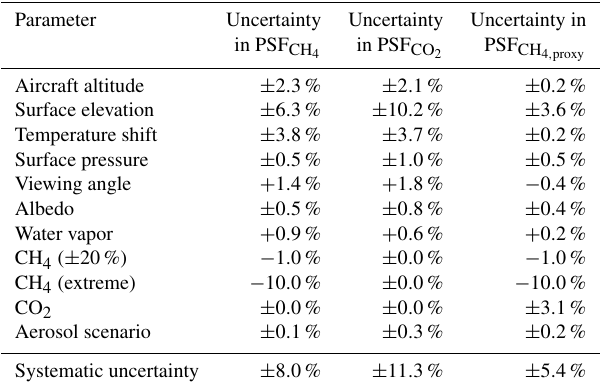
Table 4. Uncertainty estimate resulting from the assumed constant atmospheric and geometric background parameters. For each pa- rameter, the maximum deviations for PSF CH and PSF CO , as well 4 2 as for PSF CH , are listed. For albedo, the largest value was ex- 4 , proxy cluded from this table (see main text). For CH 4 , two different cases are regarded. The case CH 4 ( ± 20%) is valid for most of the plumes and is relevant for detection of smaller sources. The extreme case (100% increase) is only relevant near very strong sources and is excluded from the averaged systematic uncertainty. The absolutely when changing CO 2 is due to the rel- correct retrieval of PSF CO 2 atively small range of change in CO 2 investigated. However, this induces relatively large uncertainties in PSF CH . 4 , proxy Figure 5. Raw retrieval results of CH 4 (pure PSF CH and destriped, no proxy method applied) over a scene with large forest areas and a lake as an example of a dark scene. The retrieval produced large noise over surfaces with low spectral reflectance like forests or